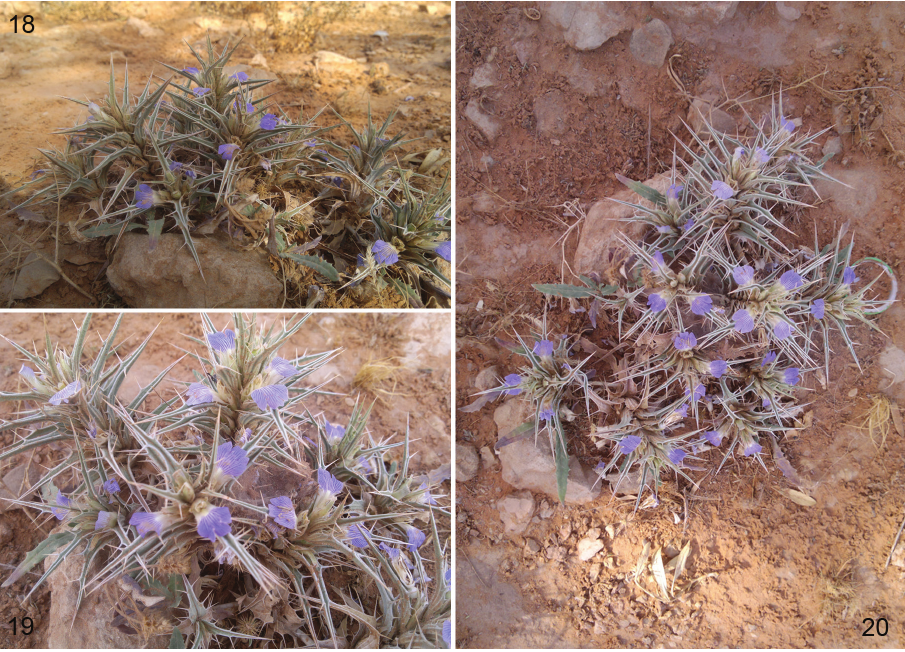
Key to genera and subgenera of Megachilini of Saudi